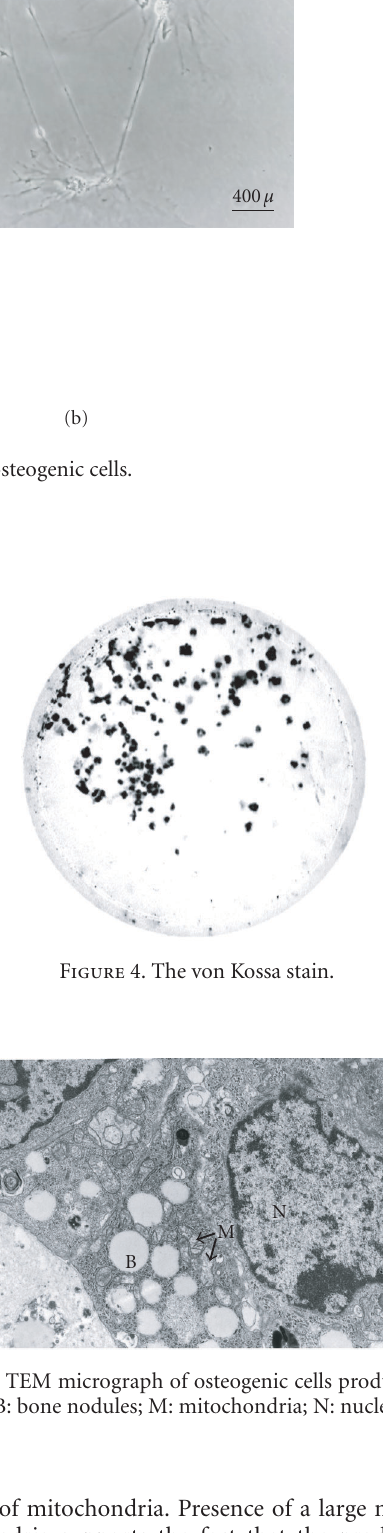
amount of mitochondria. Presence of a large number of mitochondria supports the fact that the production of bone nodules is an energy-demanding